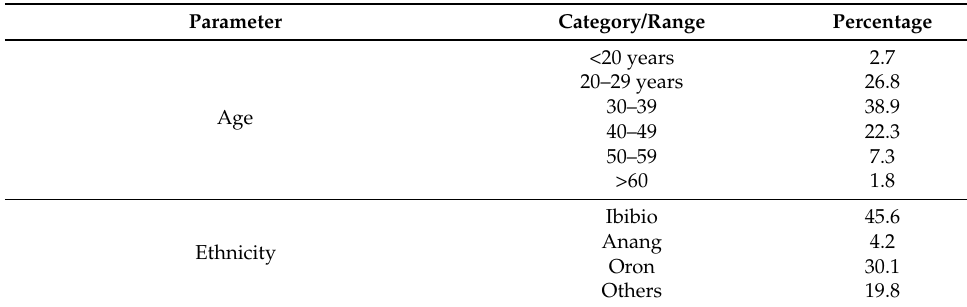
Table 1. Summary statistics for demographic and exposure characteristics at the study